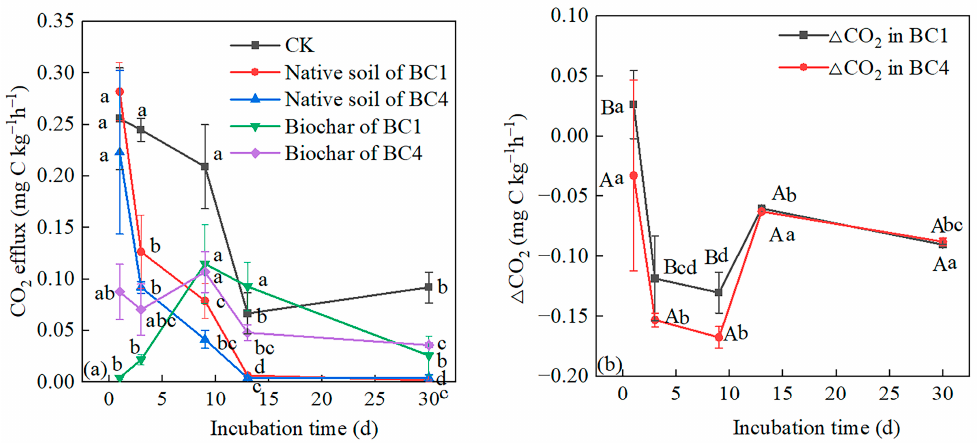
Figure 4. CO 2 efflux derived from the ( a ) native soil, biochar and ( b ) ∆ CO 2 in soils added with 1% and 4% biochar additions during the 30-day incubation. ∆ CO 2 is the difference in CO 2 efflux from native soil between biochar addition treatment and CK, i.e., the priming effect of biochar. Different capital letters indicate significant differences among different treatments at the same incubation period, and different lowercase letters indicate significant differences among different incubation time at the same treatments ( p < 0.05). Vertical bars indicate the standard error of the mean (n = 3).